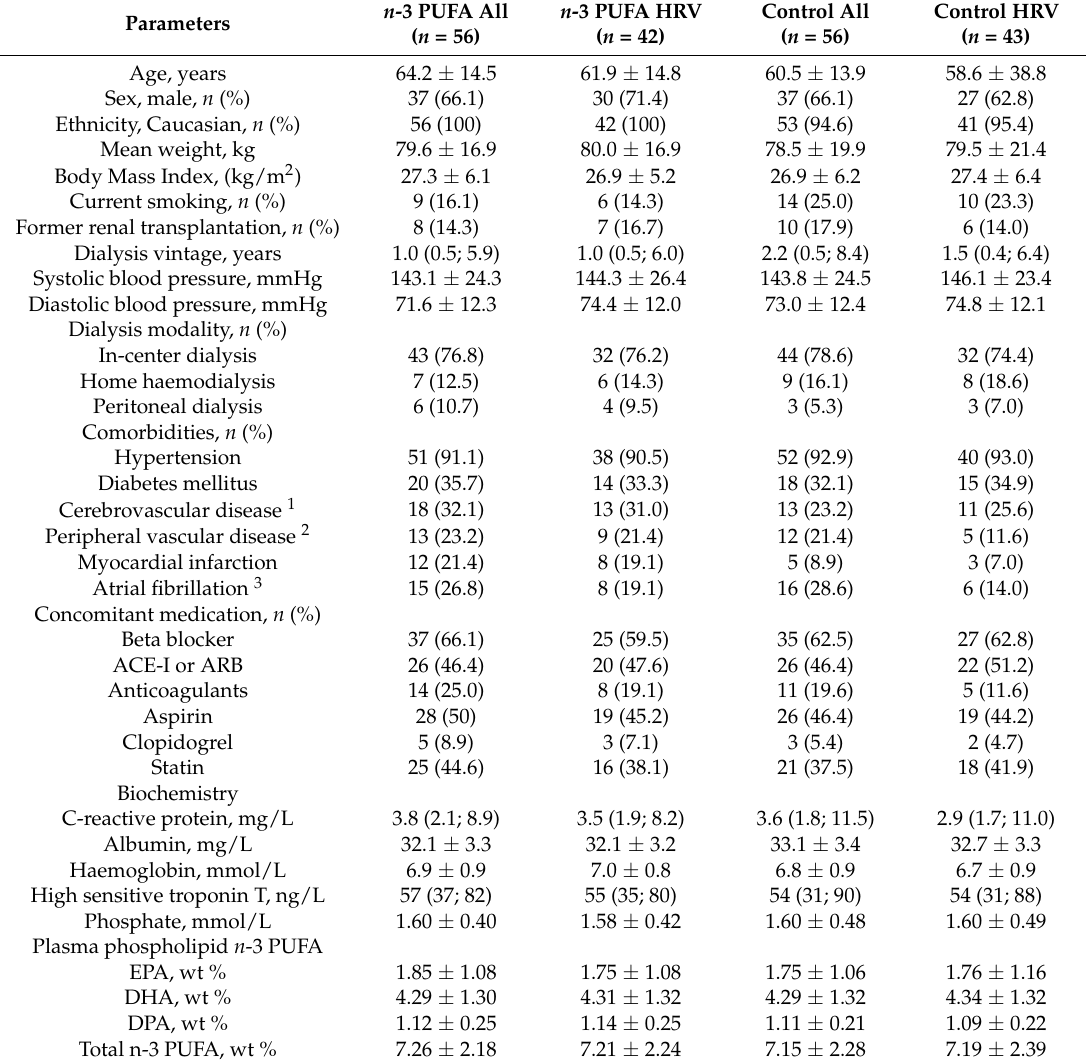
Table 1. Baseline characteristics of all randomized patients and patients included in the final HRV